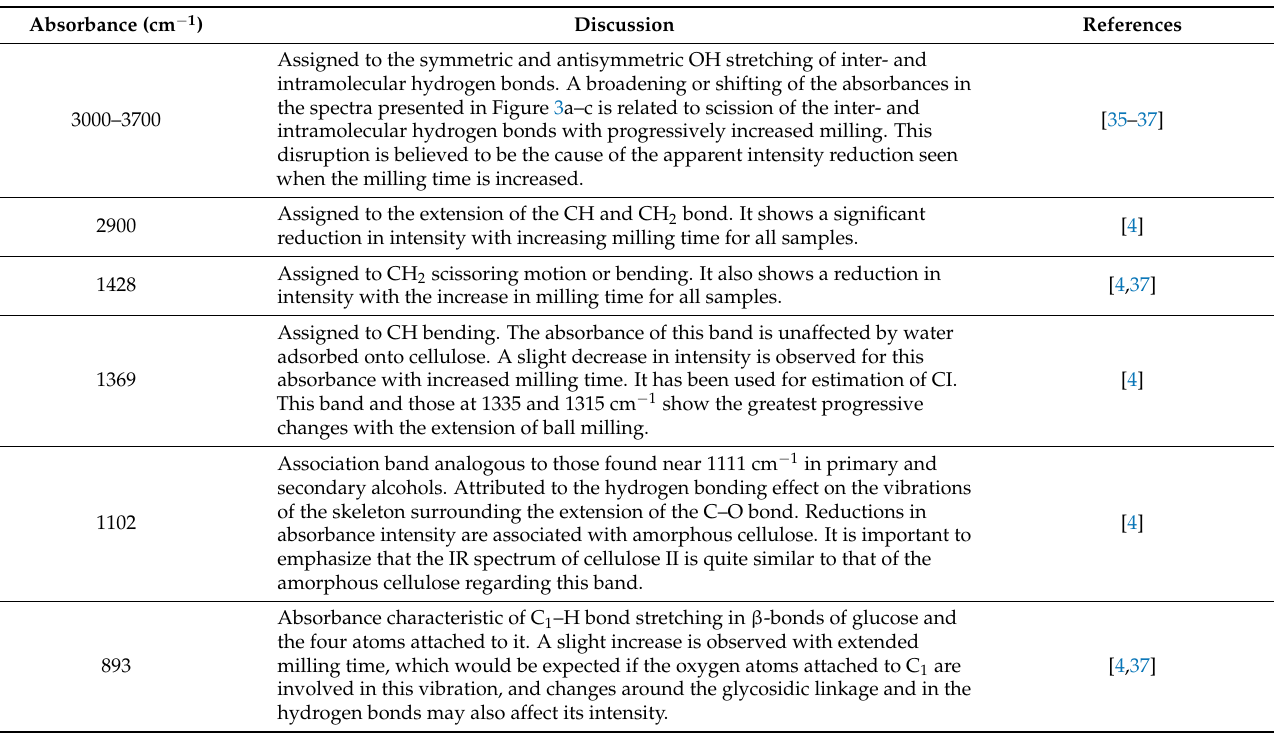
Table 2. Main absorbances associated with changes in the crystalline structure of the BR, CS, and BC samples.